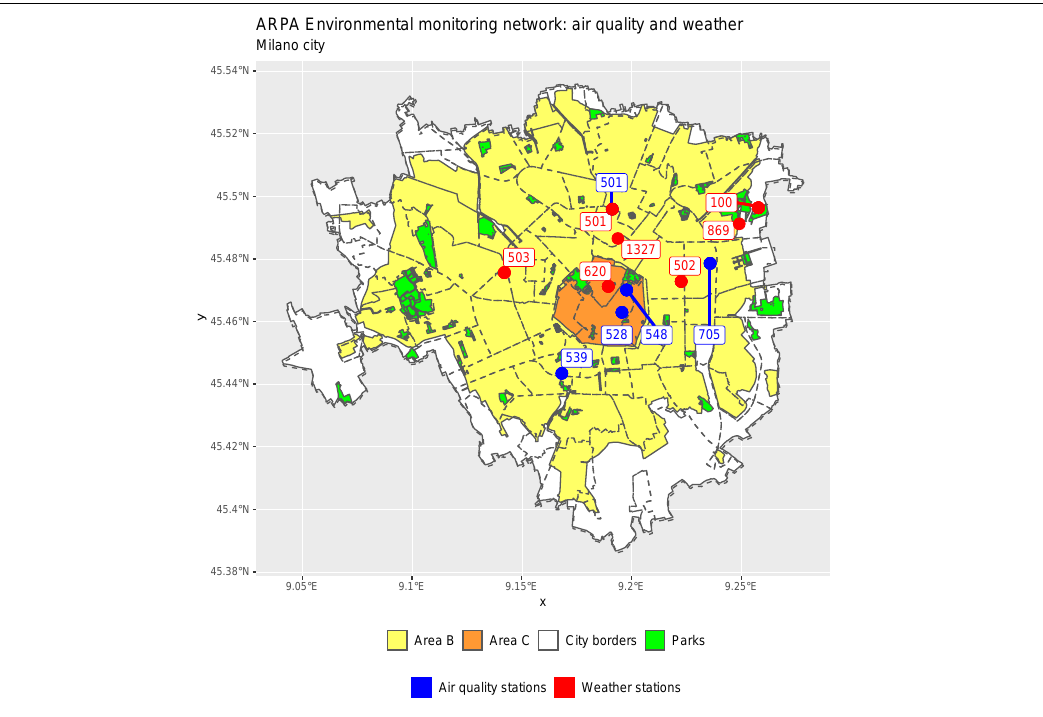
Figure 2. Monitoring system in Milan. Air quality stations (blue points): Marche (501), Verziere (528), Senato (548), Liguria (539) and Città Studi (705). Weather stations (red points): Lambrate (100), Zavattari (503), Brera (620), Feltre (869), Rosellini (1327), Juvara (502), and Marche